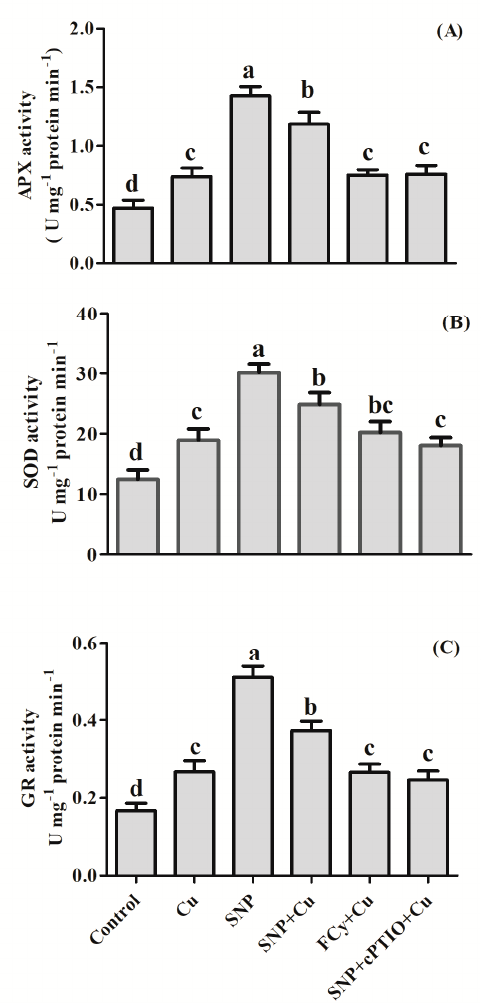
Figure 10. APX ( A ), SOD ( B ) and GR ( C ), activity in leaves of Indian mustard ( Brassica juncea L.) at 30 DAG. Plants were grown with/without Cu stress and treated during pre-germination for 3 h with water, SNP, FCy (SNP analogue) and SNP + cPTIO (cPTIO as a specific NO-scavenger). Same letters above bars show that data did not differ significantly by LSD test at p < 0.05.